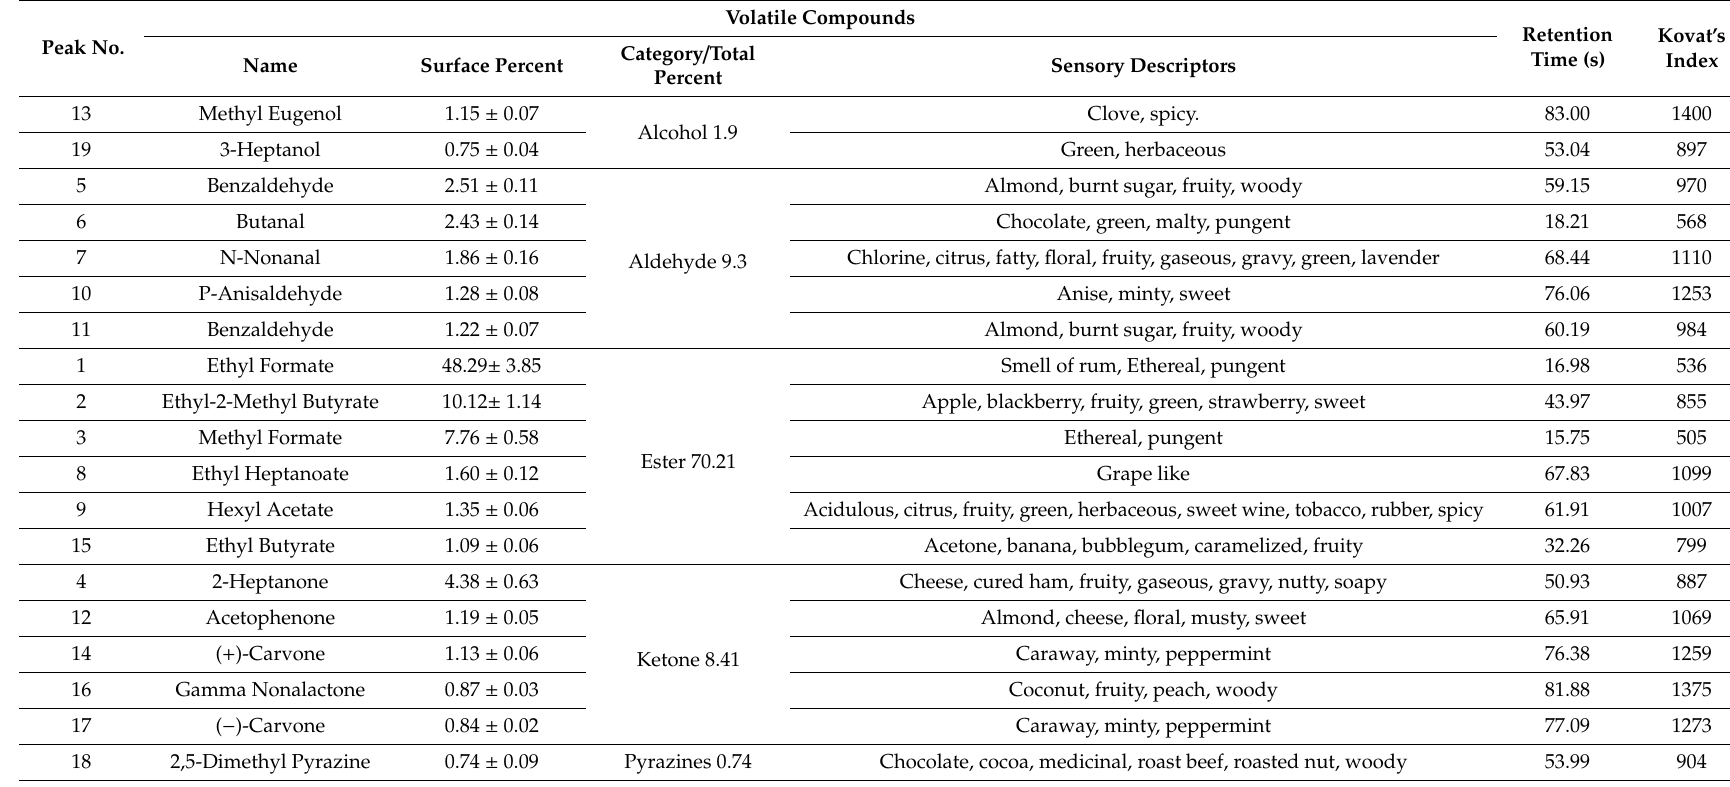
Table 4. Headspace volatile compounds of soybean variety: